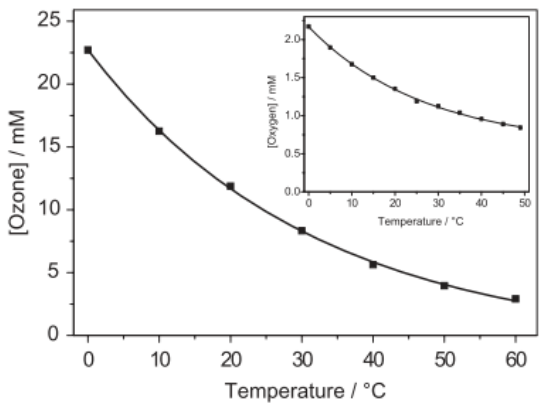
Figure 13. The solubility of ozone and oxygen in the water as a function of the temperature for pure gases. Reproduced from Ref. [90]. Copyright 2012 IWA Publishing.